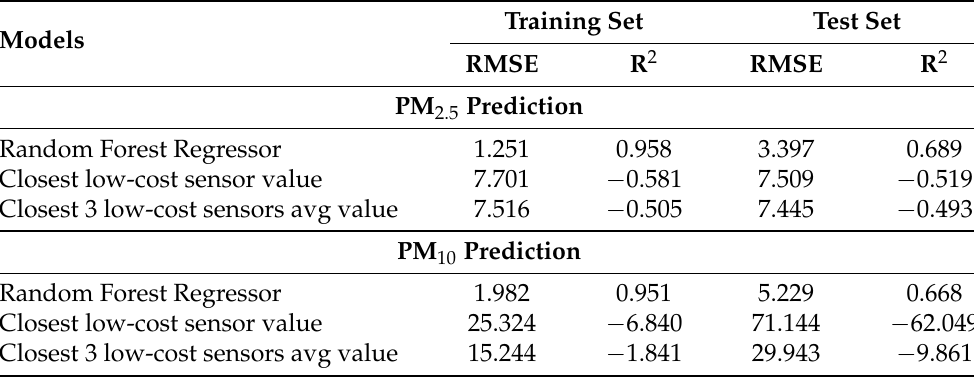
Table 5. Pollutants prediction based on low-cost sensor data. Data collected between 15